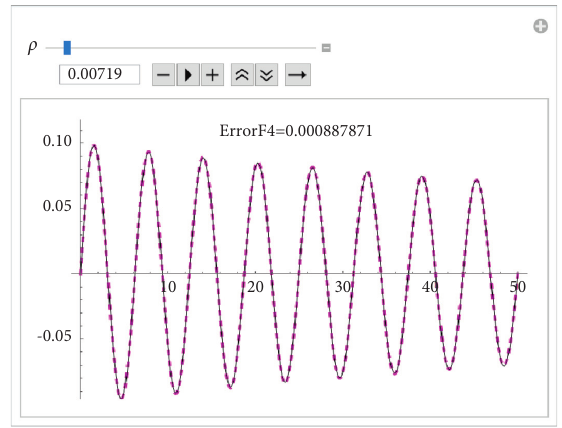
Figure 4: Method using the fourth approach-error comparison with the Runge–Kutta numerical